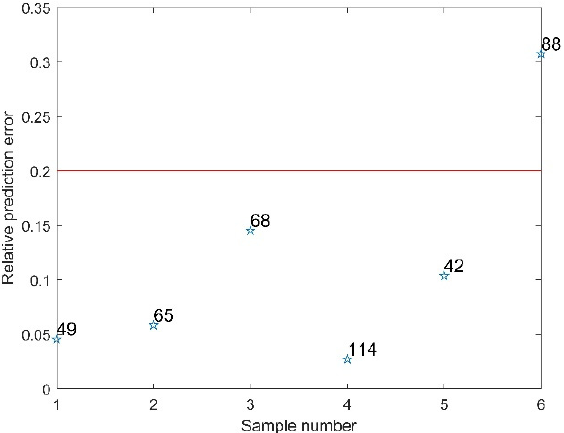
Figure 7. K-means LOOCV detection of abnormal sample results. Table 3. K-means clustering results.